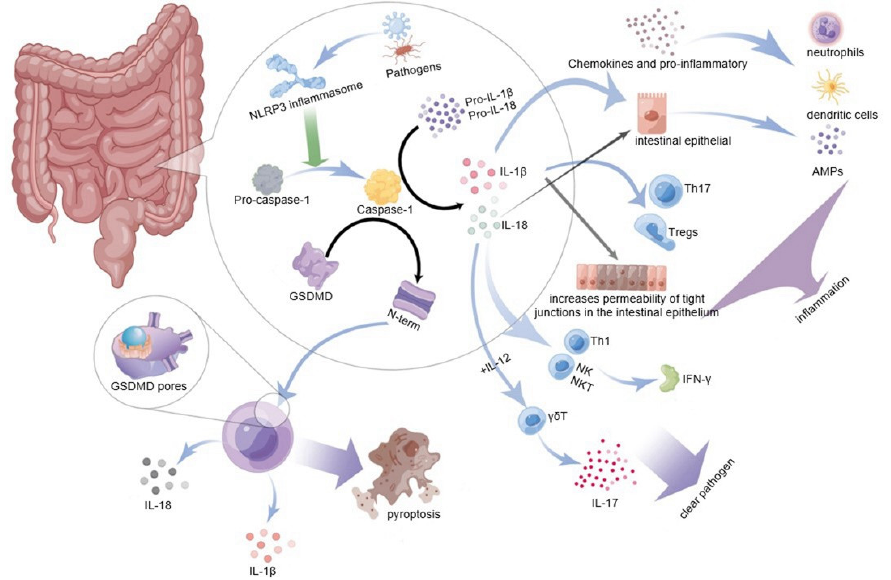
Figure 2. NLRP3 inflammasome in the intestine recognizes bacteria, viruses, or other pathogens and promotes the activation of pro-cassase-1 to caspase-1. On the one hand, caspase-1 will cleave GSDMD to produce an active segment N-terminal, which can bind to the cell membrane to form many 10–14 nm holes to cause pyroptosis and release IL-1 β and IL-18 to promote inflammatory reaction. On the other hand, activated caspase-1 activates pro-IL-1 β and pro-IL-18, activated IL-1 β, further inducing the expression of inflammatory cytokines and chemokines in the inflammatory part; it can promote the recruitment and activation of neutrophils and dendritic cells in the inflammatory part, and promote the differentiation of Th17 and Tregs. IL-18 can activate intestinal epithelial cells to produce AMPs, stimulate the production of Th1, NK, and NKT to secrete IFN- γ , or combine with IL-12 to induce more γδ T cells which secrete IL-17. NLRP3 inflammasome promotes the local inflammatory response of the intestinal and helps remove the pathogenic factors invading the body to maintain intestinal homeostasis through the above way (diagram by